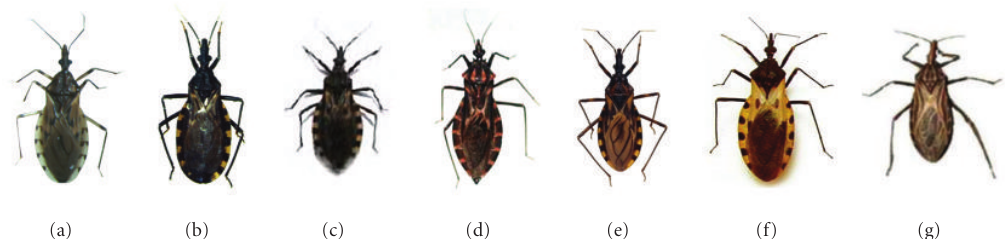
Figure 1: Some of Triatominae insects from the Reduviidae family, which are epidemiologically more significant as potential vectors: (a) Triatoma sordida ; (b) Triatoma infestans ; (c) Triatoma pseudomaculata ; (d) Panstrongylus megistus ; (e) Triatoma brasiliensis ; (f) Triatoma dimidiata ; (g) Rhodnius prolixus .